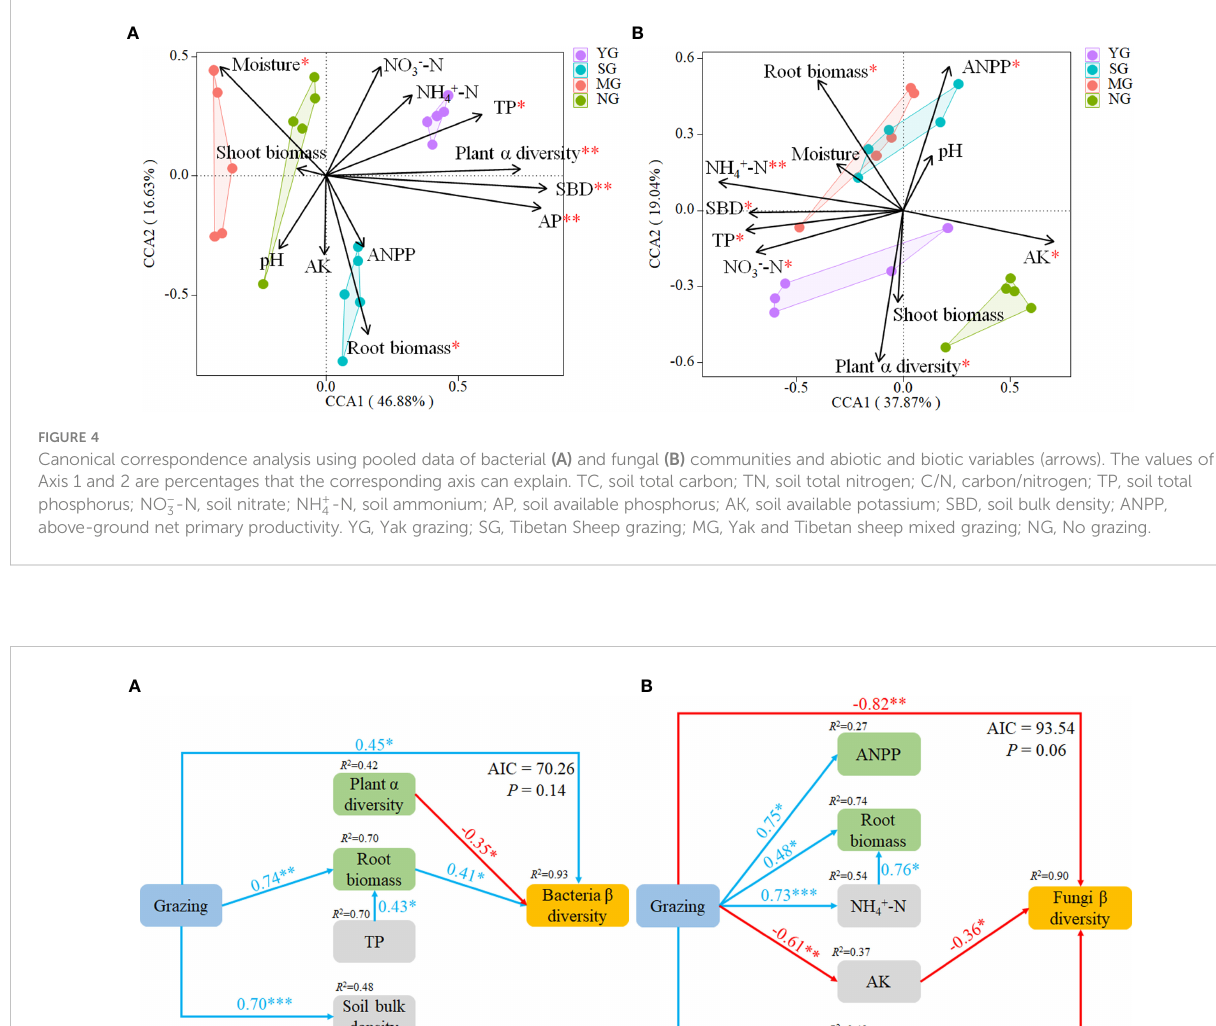
FIGURE 5 Piecewise structural equation model (SEM) describing the effects of grazing on soil bacteria (A) and fungi (B) b diversity. TP, soil total phosphorus; NH + 4 -N, soil ammonium; AK, soil available